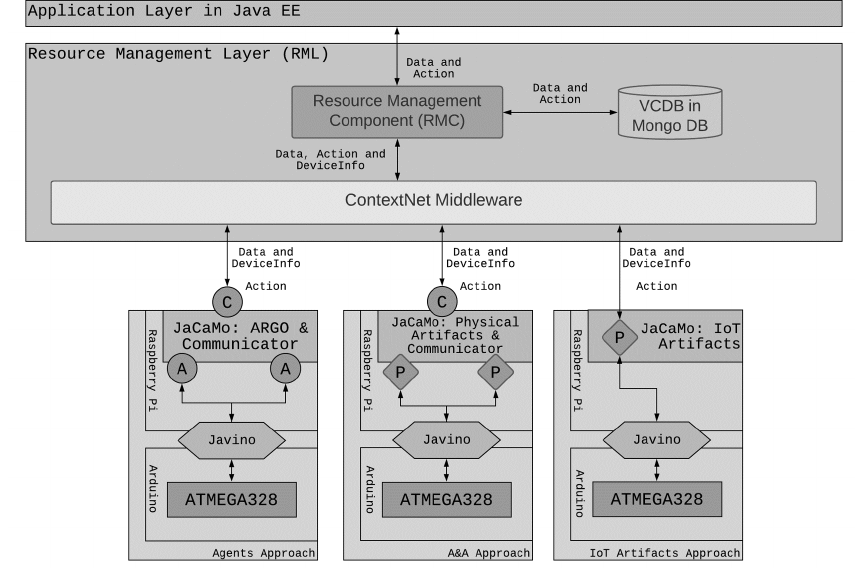
Figure 5. The technological view of components considering the IoT Objects employed in tests and the Engineering approaches in extended